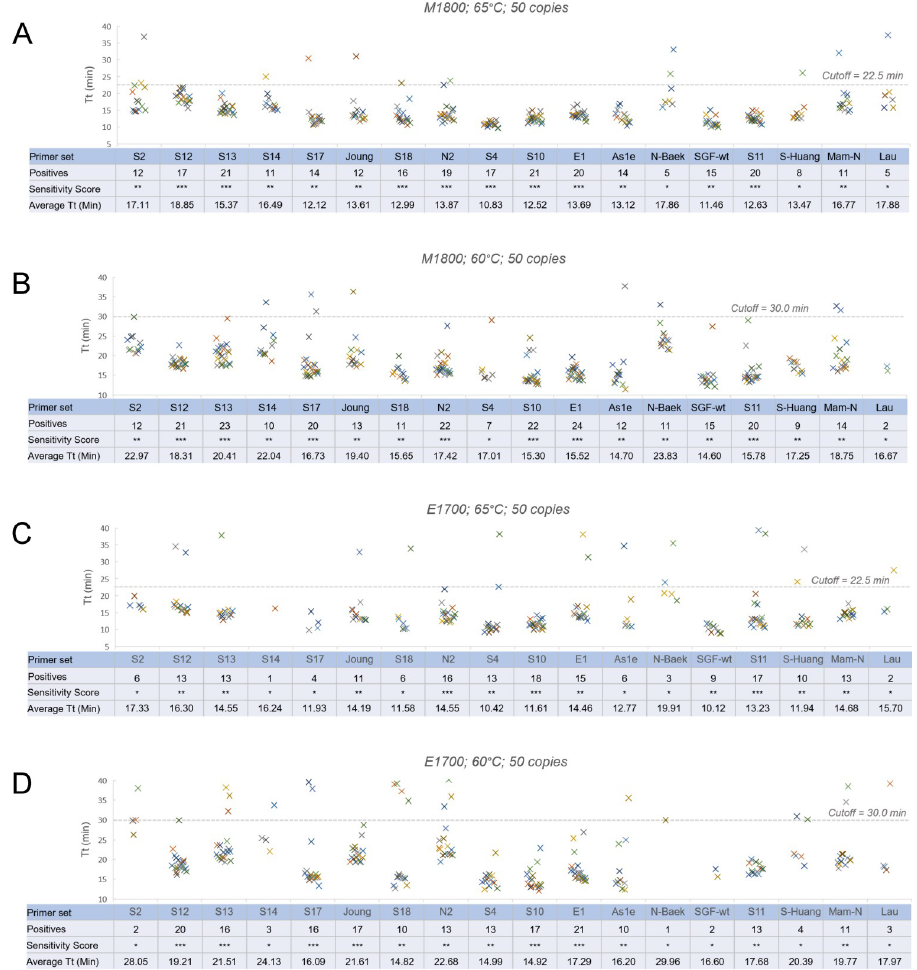
Fig 1. Performance of single primer sets. Each primer set was assayed with 24 repeats with 50 copies of SARS-CoV-2 RNA template per reaction. Each primer set was assigned a sensitivity score: sensitive ( ��� 16–24 positives); medium ( �� 9–15 positives) or poor ( � 1–8 positives). (A) RT-LAMP reactions conducted with M1800 Colorimetric LAMP at 65˚C. (B) With M1800 at 60˚C. (C) With E1700 LAMP Mix at 65˚C. (D) With E1700 at 60˚C. necessarily linked. Reaction speed for 16 of the 18 primer sets decreased (by 3.9 ± 1.5 minutes)